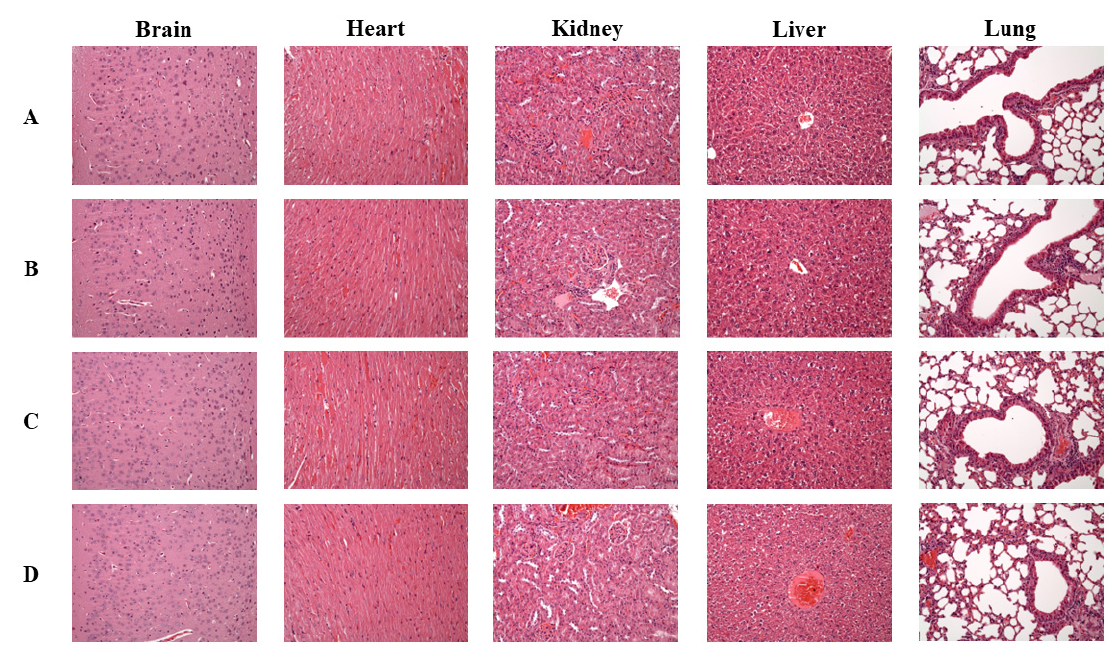
Figure 2. Effects of SPE treatment on histology of the brain, heart, liver, kidney, and lung of male Figure 2. EffectsofSPEtreatmentonhistologyofthebrain,heart,liver,kidney,andlungofmaleSAMP8mice SAMP8 mice (100×). Group ( A )—control group, Group ( B )—low-dose SPE (61.5 mg/kg BW/day), (100 × ). Group ( A )—control group, Group ( B )—low-dose SPE (61.5 mg/kg BW/day), Group ( C )—medium- Group ( C )—medium-dose SPE (123 mg/kg BW/day), and Group ( D )—high-dose SPE (184.5 mg/kg dose SPE (123 mg/kg BW/day), and Group ( D )—high-dose SPE (184.5 mg/kg BW/day). BW/day).